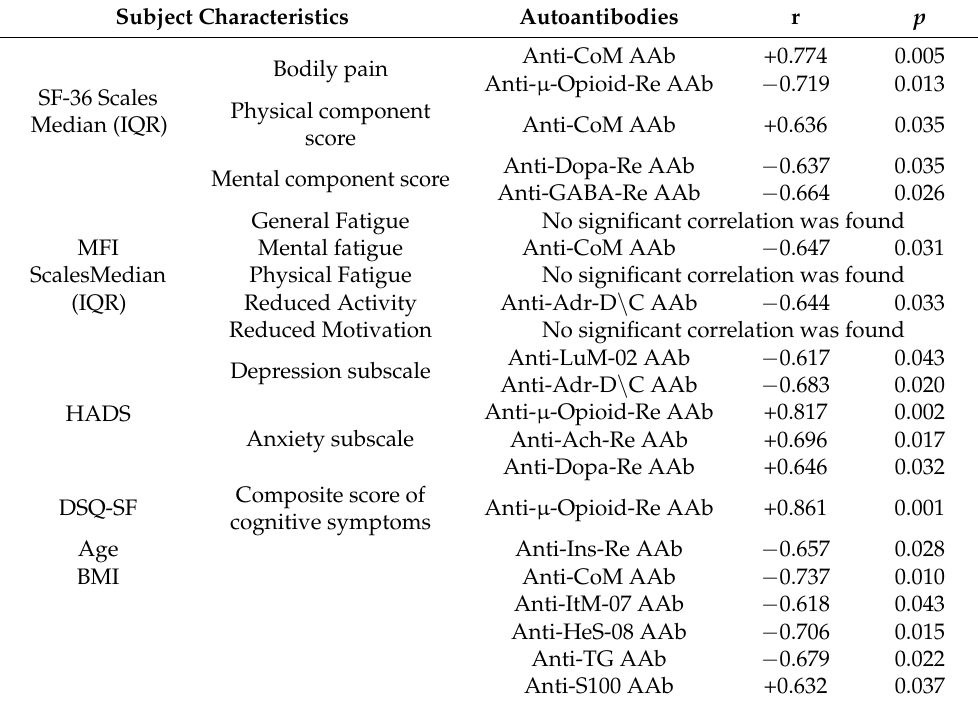
Table 7. Clinical correlations of the absolute AAb deviations from AIR in HC group. (Spearman correlation coefficient r and p -value).